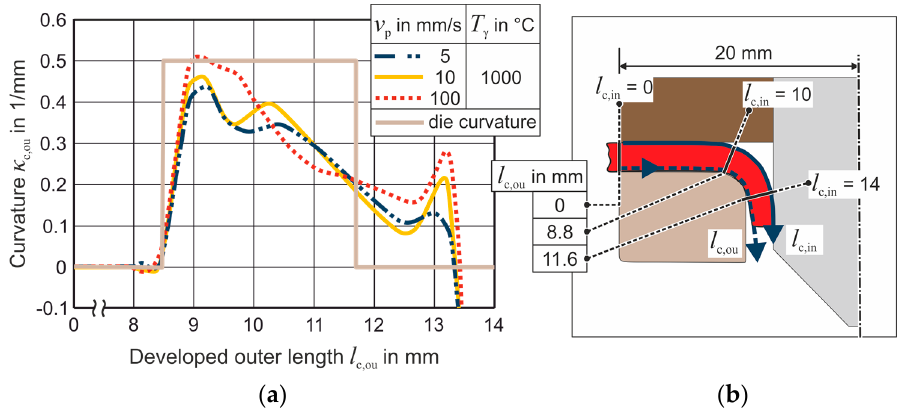
Figure 8. ( a ) Ideal curvature of the die and curvature κ along the developed outer length l c,ou for different punch velocities v p ; ( b ) Definition of the developed outer length l c,ou